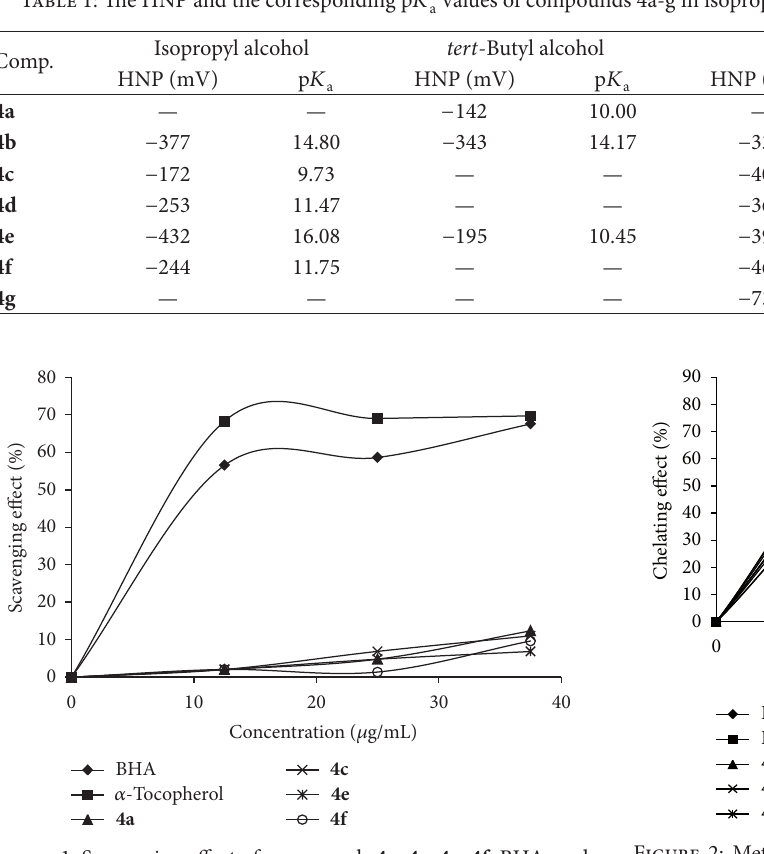
F 2: Metal chelating effect of different amount of the com- pounds 4a–g , BHT, and BHA on ferrous ions.